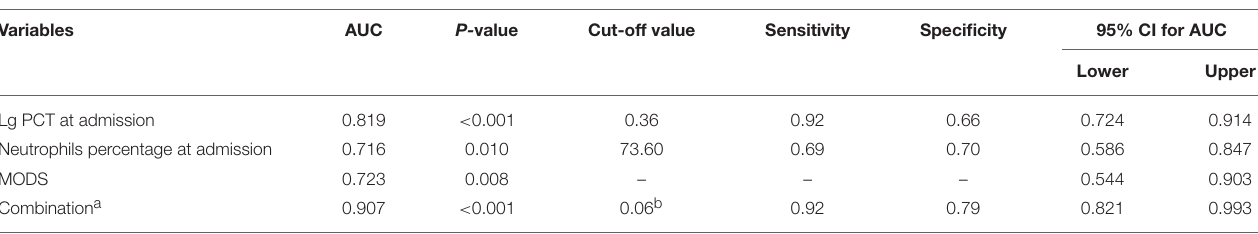
TABLE 8 | Predictive values of parameters for mortality of HFRS